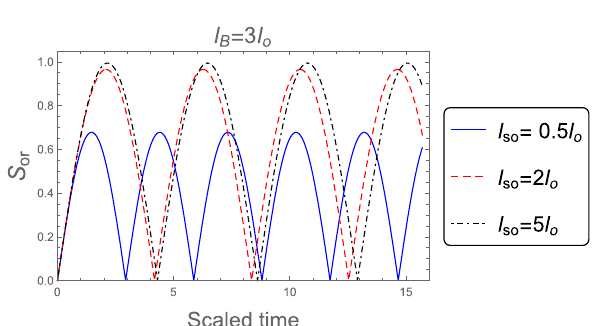
3 l o is applied. =